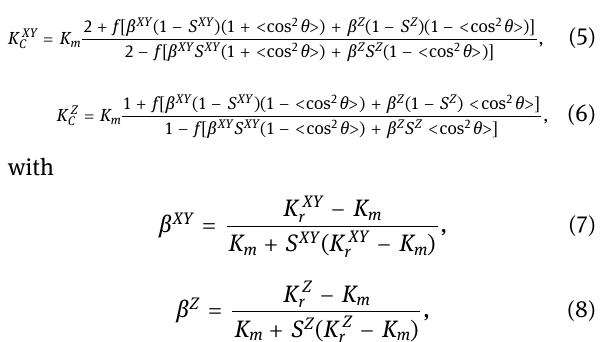
Figure 2: Schematic diagram of the X – Y plane and the Z - direction of graphite fl akes/Al